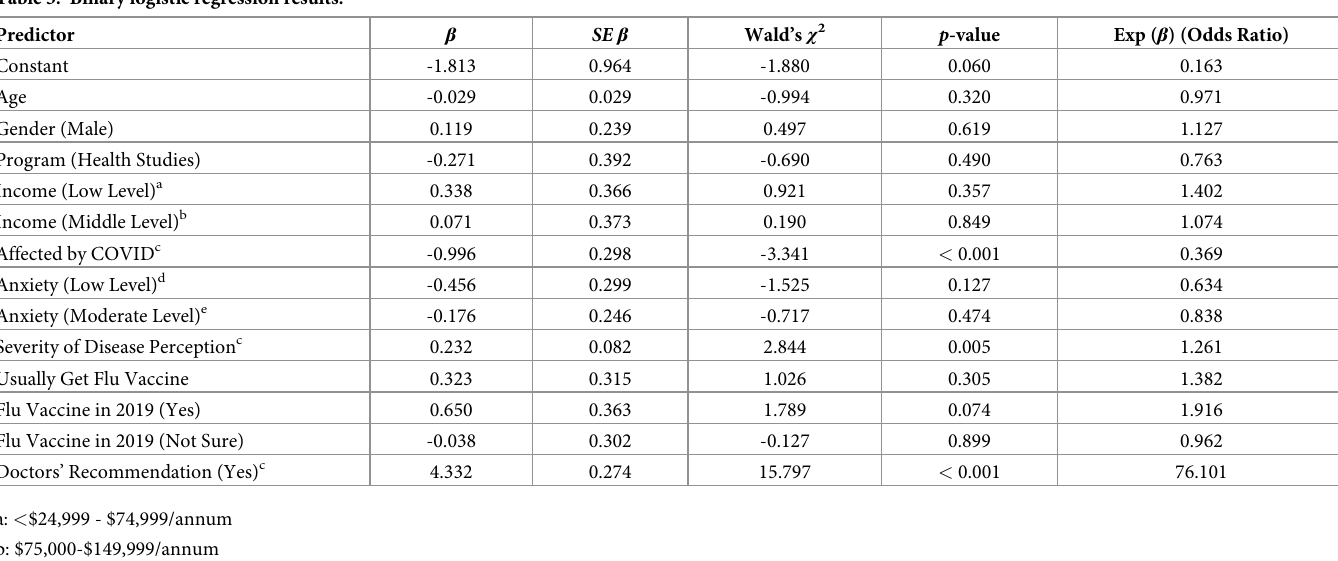
Table 5. Binary logistic regression